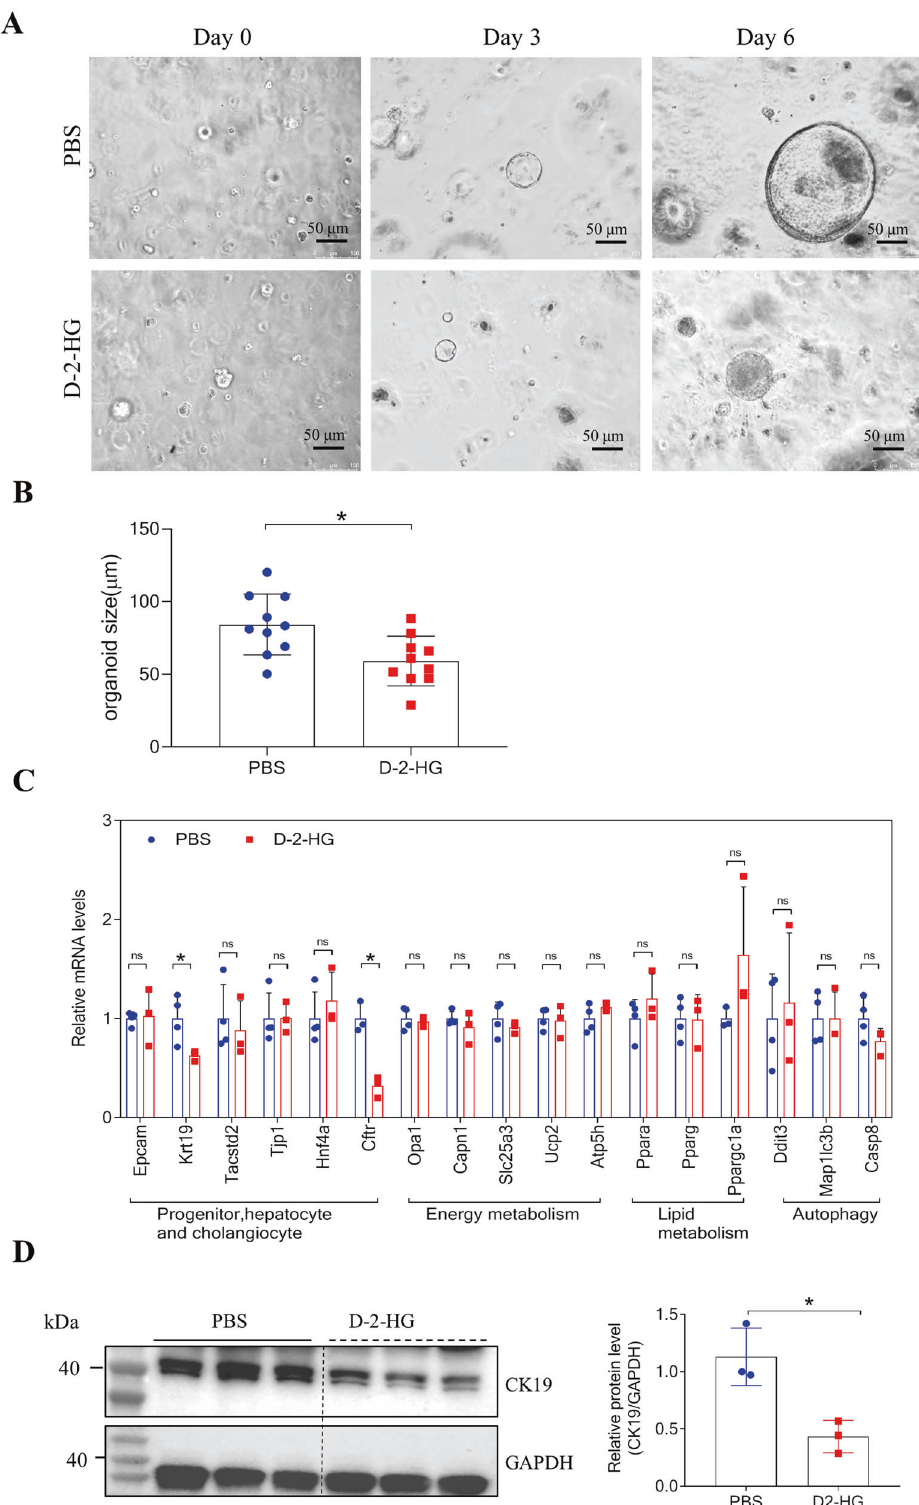
Fig. 4 D-2-HG restrained the growth of liver organoids. A Representative size and morphology of culture organoids treated with PBS, or 5 mM D-2-HG at the indicated time. B Quanti fi cation for the size of organoids in panel ( A ). C The relative expression of involved genes mRNA in the liver organoids with or without 5 mM D-2-HG exposure. D At 4 h after PBS or 5 mM D-2-HG exposure, the proteins of the EpCAM + cells were extracted for western blotting (WB). Representative images of WB for CK19. Quanti fi cation of CK19 against GAPDH. ns, not signi fi cant, * P <